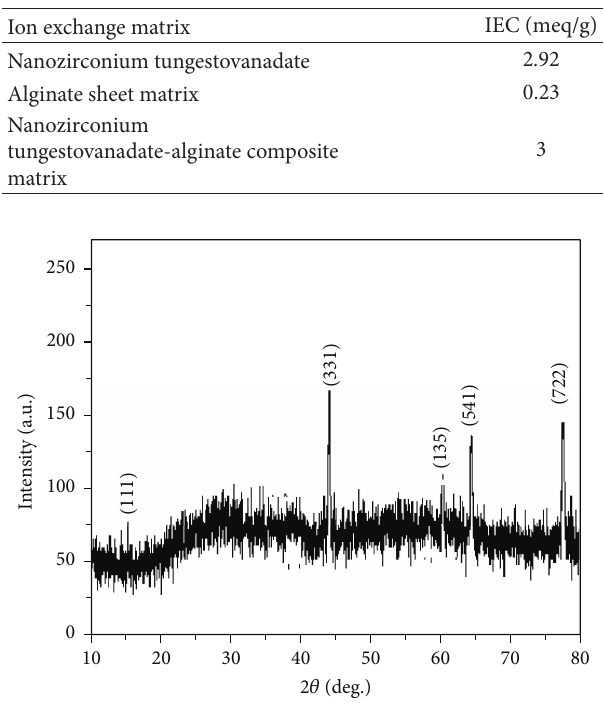
Figure 2: XRD patterns of fabricated zirconium tungestovanadate immobilized onto alginate matrix.